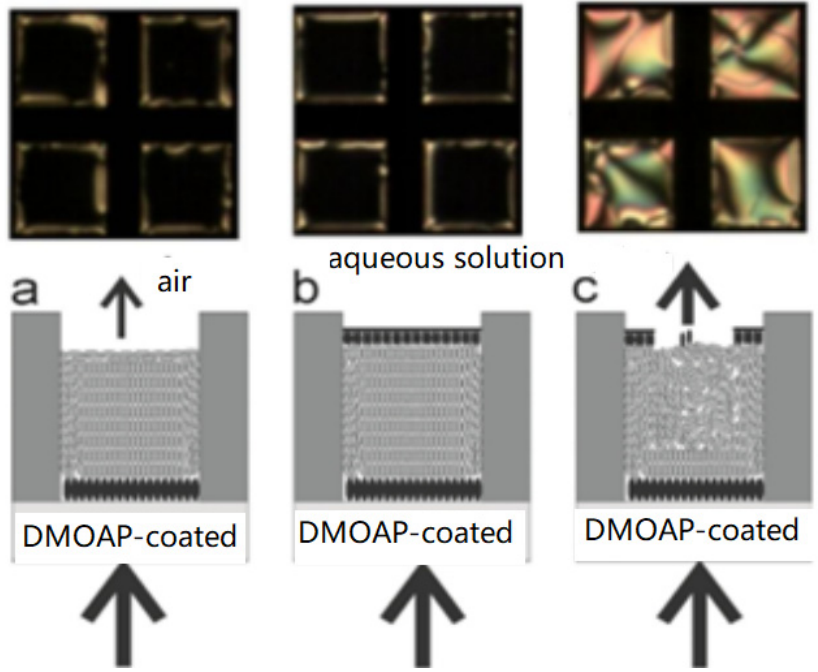
Figure 5. Schematic representation of an LC-based sensor consisting of a gold grid compartment, a silanized glass substrate and LCs; the arrows indicate the transmission of light: ( a ) LCs appear aligned near the substrate and slightly disordered near the air interface. ( b ) LCs exhibit homeotropic alignment near an aqueous environment, mediated by a lipid layer. ( c ) Destruction of the lipid layer results in disorder of the LCs [6].